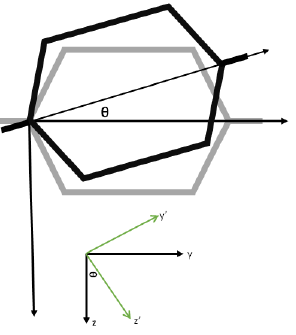
Figure A1. Cross section view of the proposed electro-optic